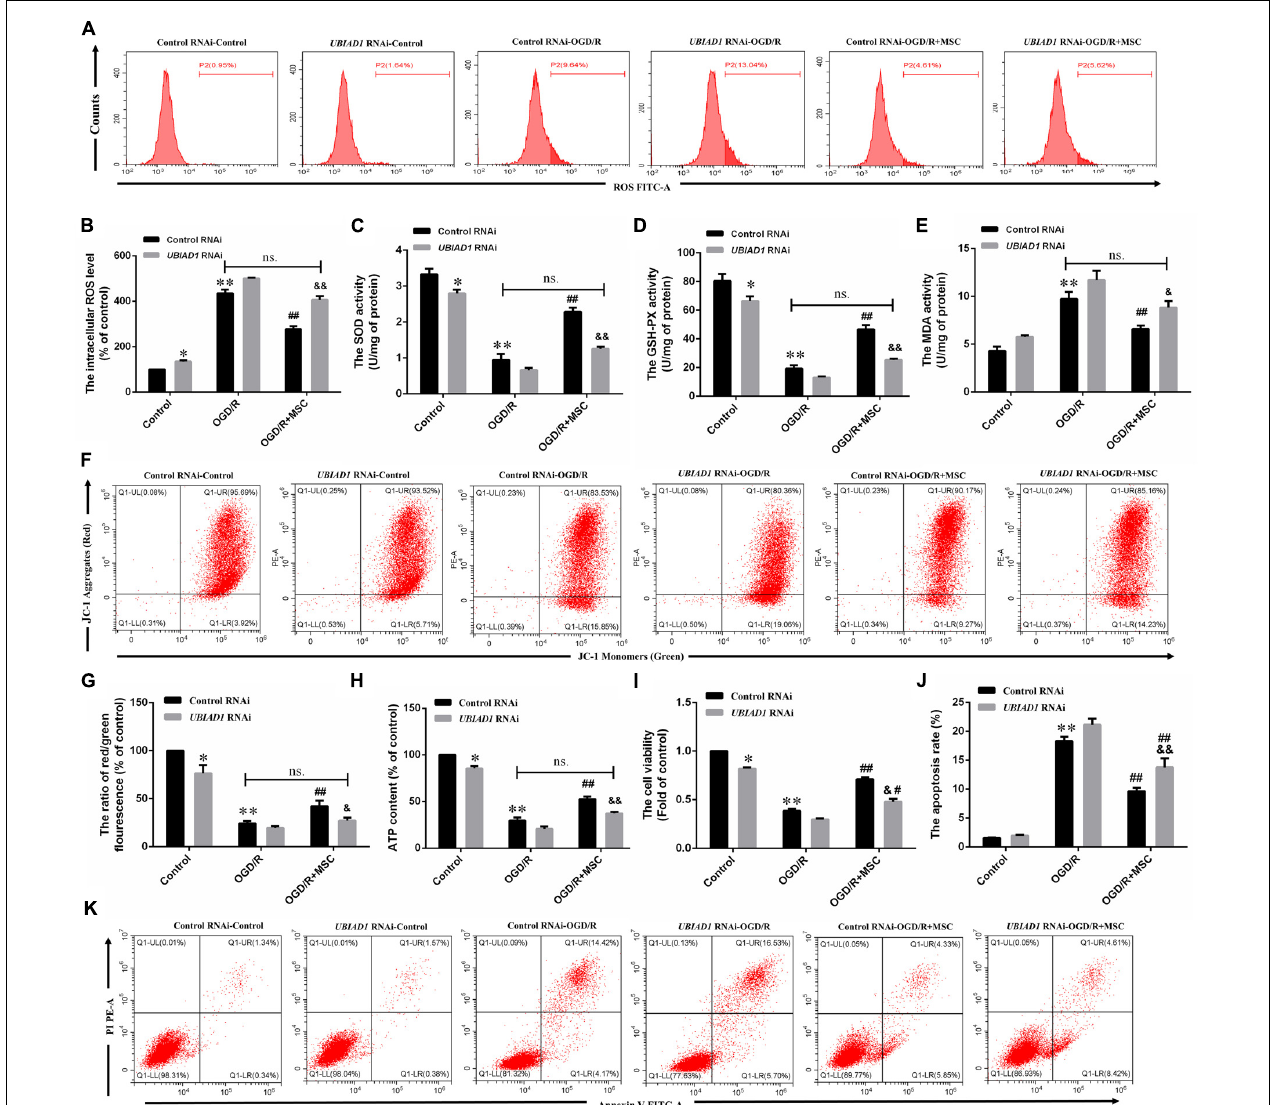
FIGURE 6 | OM-MSCs mitigate OGD/R-induced ROS overproduction and mitochondrial dysfunction through upregulation of UBIAD1. N2a cells were transfected with UBIAD1-specific siRNA (UBIAD1 RNAi) or a non-specific control siRNA. (A,B) The intracellular ROS levels were examined by DCFH-DA in N 2 a cells knocked down by UBIAD1. (C–E) The total SOD, GSH-PX, and MDA activities in N 2 a were assessed. (F–G) Determination of the mitochondrial membrane potential was carried out using the JC-1 probe. (H) The ATP content in N 2 a cells. (I) The cell viability was examined by CCk-8 assay. (J,K) The apoptotic N2a cells knocked down by UBIAD1. All data are displayed as mean ± SEM ( n = 3). ( ∗ P < 0.05, ∗∗ P < 0.01 vs. Con/control RNAi, # P < 0.05, ## P < 0.01 vs. OGD/R/control RNAi, & P < 0.05, && P < 0.01 vs. OGD/R + MSCs/control RNAi, ns. no